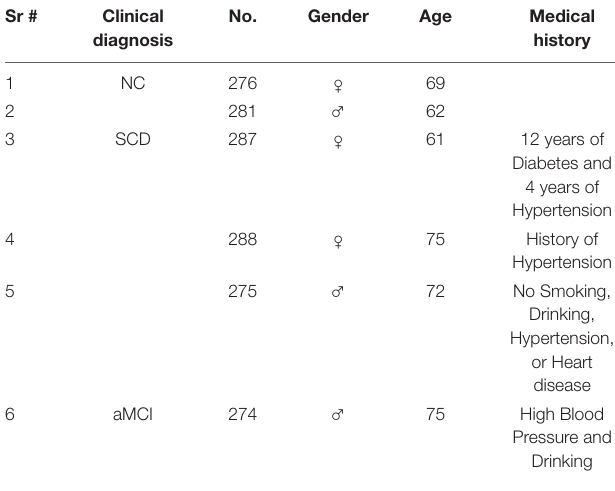
TABLE 1 | Clinical details of specimens for circRNA microarray